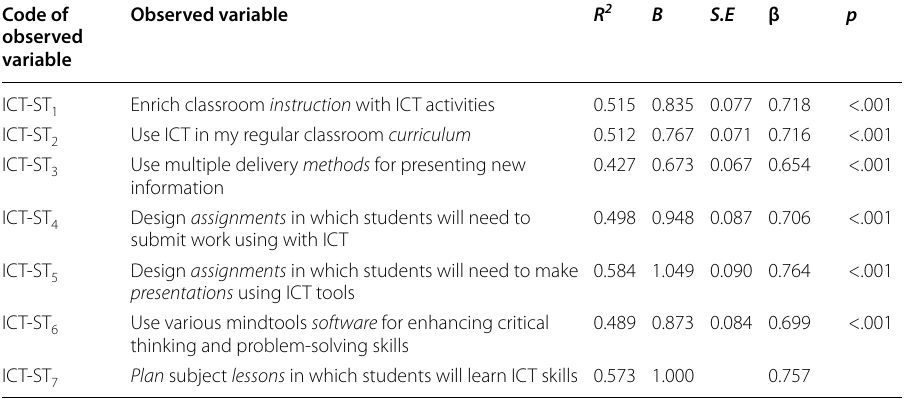
Table 7 Standardized and unstandardized coefficients of the latent variable ICT self-efficacy in teaching